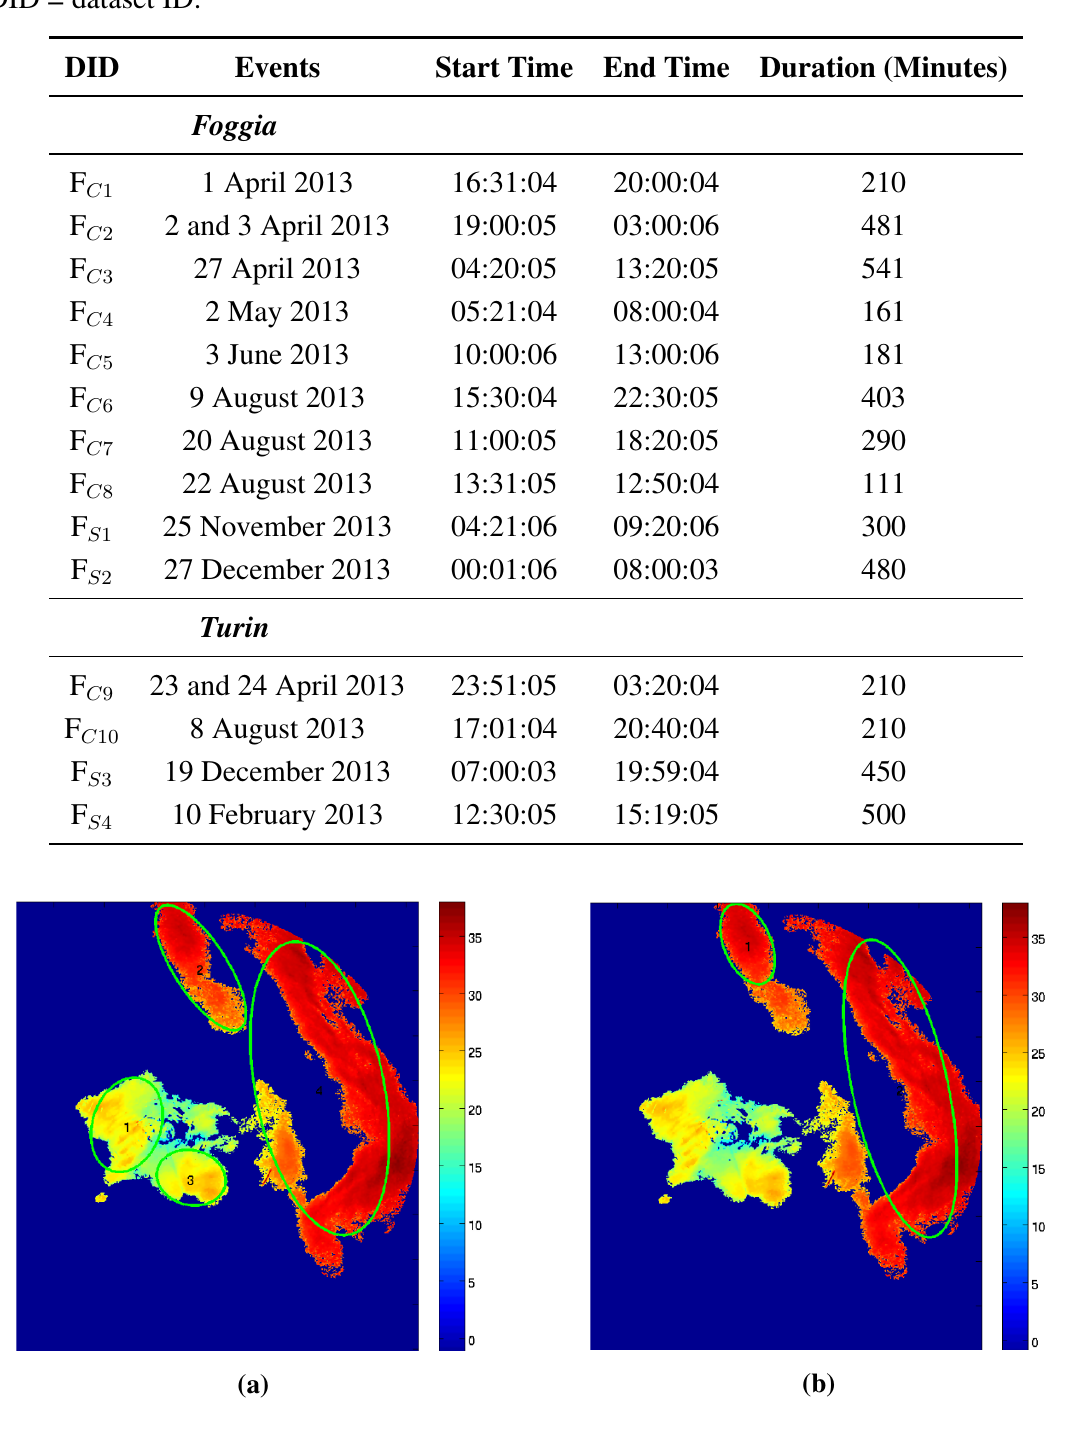
Figure 5. Comparison of automatic threshold calculation and user randomly selected